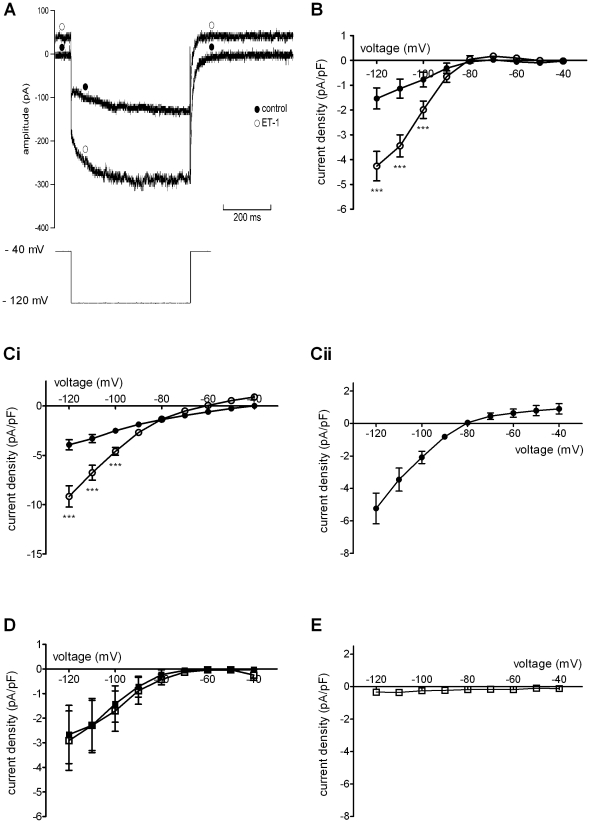
ET-1 effects on the hyperpolarisation-activated current If.A. Upper traces show currents elicited −120 mV in an If-expressing cell in control solution and 10 nM ET-1 by protocol shown in bottom trace. Note outward shift in holding current in presence of ET-1. Closed circles indicate control trace; open circles indicate trace in ET-1. B. Mean I–V relationships (n = 7) for If, plotted as time-dependent current during command pulses, in absence (control, filled circles) and presence of 10 nM ET-1 (open circles). The activating effect of ET-1 was significant only at −120, −110 and −100 mV. C. Mean I–V relationships for the instantaneous current recorded at the beginning of the test-pulse (Ci: in absence (control, filled circles) and presence (open circles) of 10 nM ET-1). Cii shows I–V relation for the ET-1 activated instantaneous current (Cii, filled circles), in cells also showing If (n = 7). ET-1 activates a large inwardly rectifying current. D. I–V relations for If in presence of 1 µM BQ-123 (n = 11) without (filled squares) and with 10 nM ET-1 (open squares, n = 11 at all potentials except at −50 mV, where n = 10). BQ-123 prevented stimulation of If by ET-1. E. Inhibitory effect of 1 µM BQ-123 on the ET-1 activated current in cells exhibiting showing If (open squares, n = 12 except at −50 mV where n = 11). Asterisks denote statistical significance (p<0.001 ***).